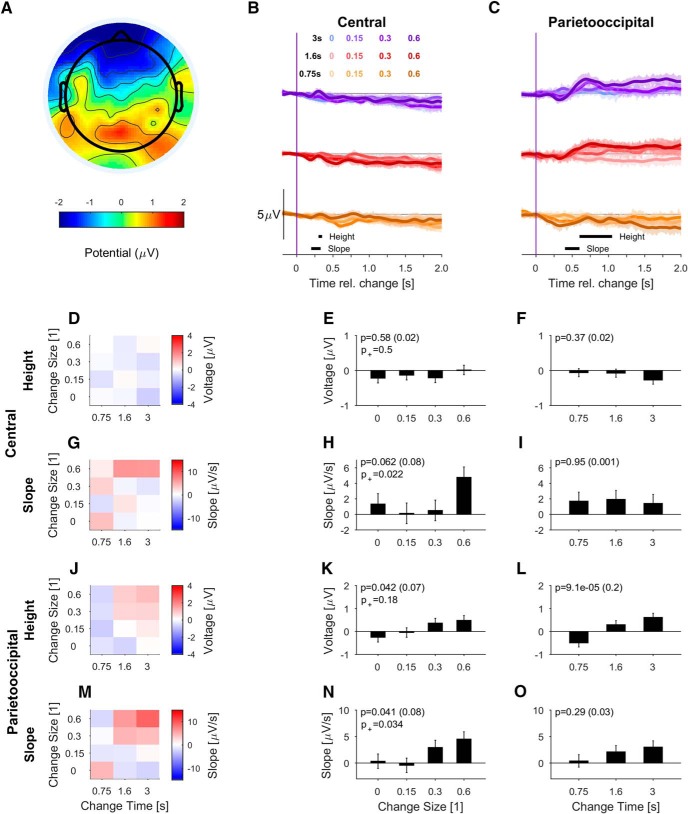
The PO potential is reduced but stays stimulus dependent for passive-aware subjects. A, The post-change scalp topography (600–700 ms) is dominated by posterior components, but the overall potential size is much smaller (only trials for MC = 0.6 included for display); however, note the scale difference in comparison to Figure 4. B, In the central electrodes, the change in statistics elicited a small ERP complex (positive peak ∼320 ms) for the longest change times and largest change sizes (colors as in Fig. 3, see legend). C, In the PO electrodes, the change in statistics also led to a slow negative-positive potential, reaching a plateau around 700 ms. D–F, The height of the central potential neither depended on change size nor time. G–I, The slope of the central potential showed a borderline significant dependence on change size, but not change time (measurement range: 200–330 ms). J, The PO potential's height varied systematically with change time and size. K, The PO potential was significantly larger for bigger change sizes; however, the size of the potential was much smaller than in the active condition, corresponding to the change in topography. L, The PO potential also increased slightly but significantly in height with change time (see Results for interpretation). M, The slope of the PO potential exhibited a similar dependence on change size and time as in the active condition (compare to Fig. 4G). N, The PO slope is significantly steeper as a for larger change sizes. O, The PO slope displayed a nonsignificant tendency to be faster for longer change times. Conventions as in Figure 4.